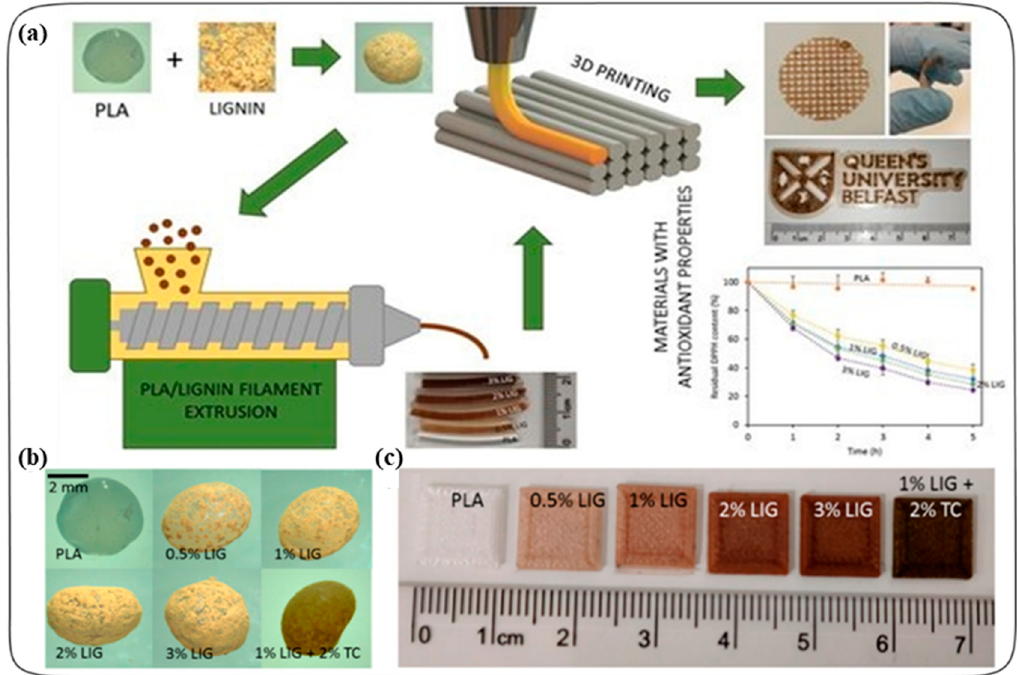
Figure 4. ( a ) Schematic representation of the experimental setup to prepare antioxidant materials used for 3D printed meshes. ( b ) Photographs of poly(lactic) acid (PLA) and PLA-coated pellets. ( c ) Lignin (LIG) and tetracycline (TC) containing squares fabricated using 3D printing. Reprinted from Ref. [39] with permission from MDPI.